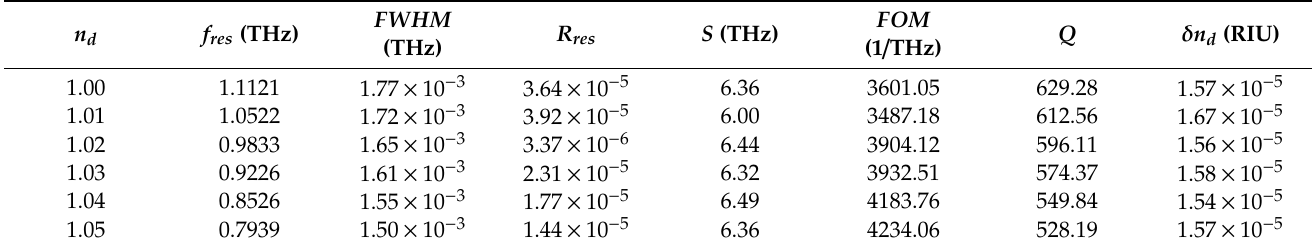
Table 2. Performance index parameters of THz-SPR sensor based on CPGS.